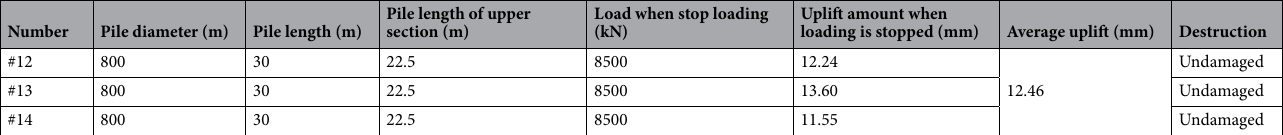
Table 3. Data sheet of the upper pile of the self-balancing method.